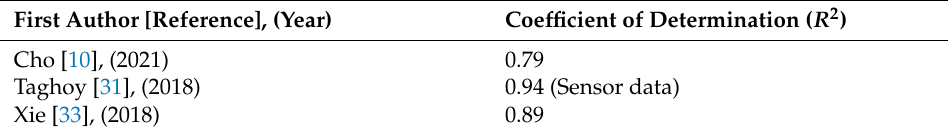
Table 3. Coefficient of determination ( R 2 ) for banana ripeness